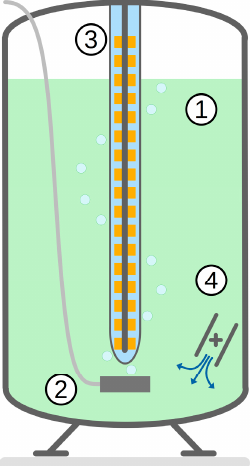
Figure 1. Schematic of the photobioreactor used for the study. 1—culture medium, 2—air sparger, 3—LED light source, 4—circulating pump. 3—LED light source, 4—circulating